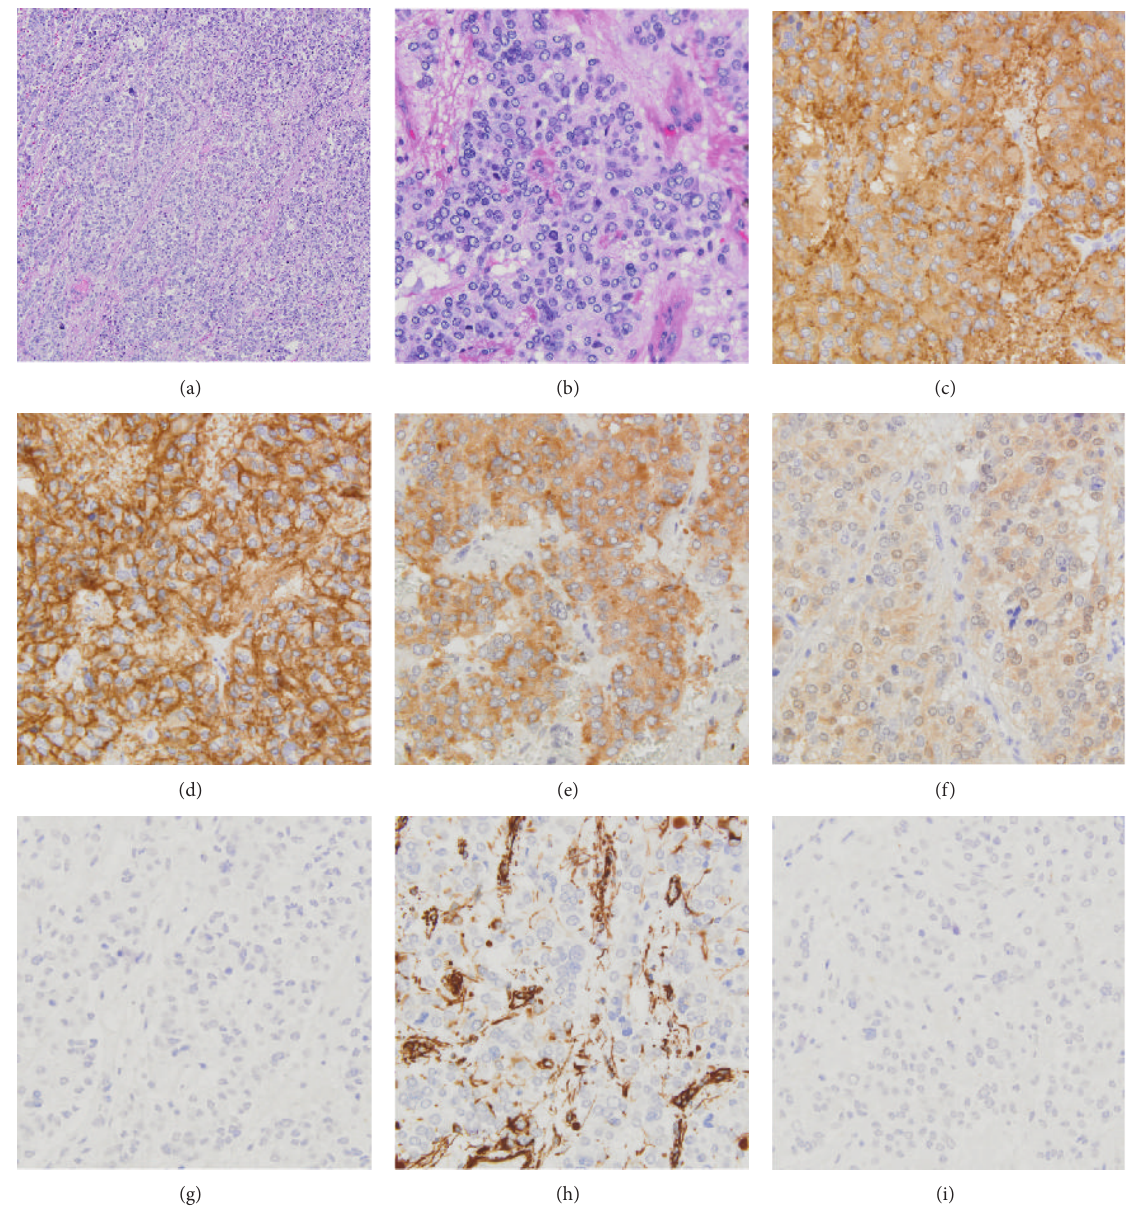
Figure 3: Intrarenal paraganglioma. Low magnification (a) and high magnification (b) of tumor cells (hematoxylin and eosin). Tumor cells forming a “Zellballen pattern” with interspersed thin-walled vascular structures. IHC showed tumor cells are positive for synaptophysin (c), CD 56 (d), and chromogranin (e). Sustentacular cells were positive for S-100, although tumor cells were negative (f). The tumor cells were negatively stained for HMB45 (g), vimentin (h), and CK7 (i).